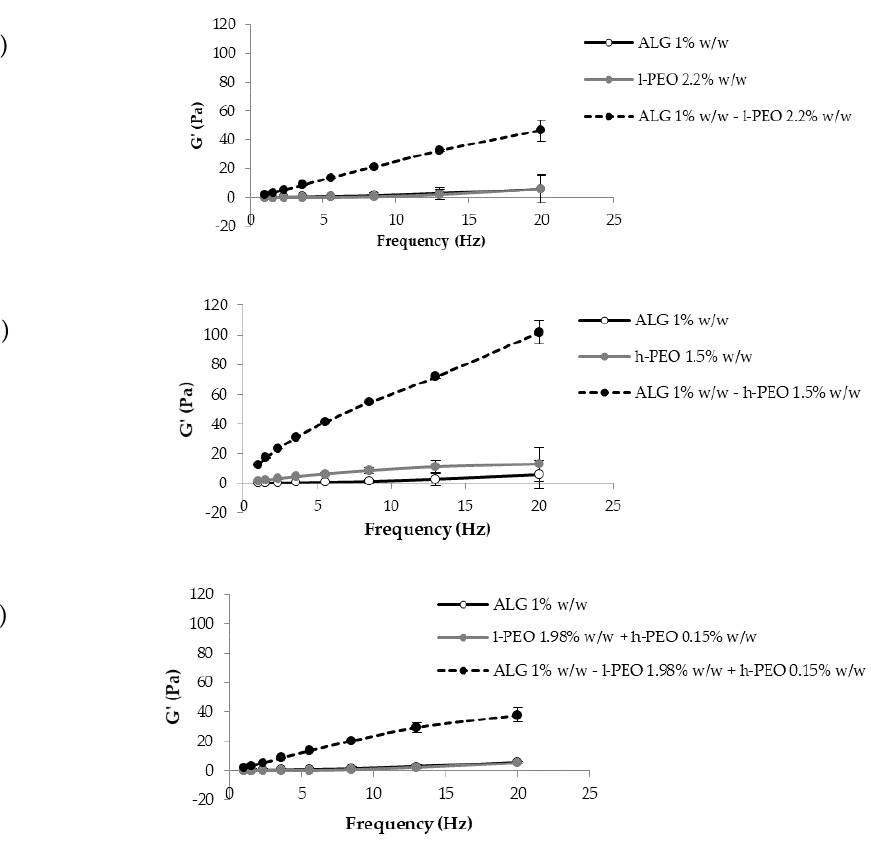
Figure 11. G (cid:48) vs. frequency profiles of blends containing ALG 1% w / w with ( a ) l-PEO 2.2% w / w , ( b ) h-PEO 1.5% w / w , and ( c ) l-PEO 1.98% w / w /h-PEO 0.15% w / w (mean values ± SD; n = 3).